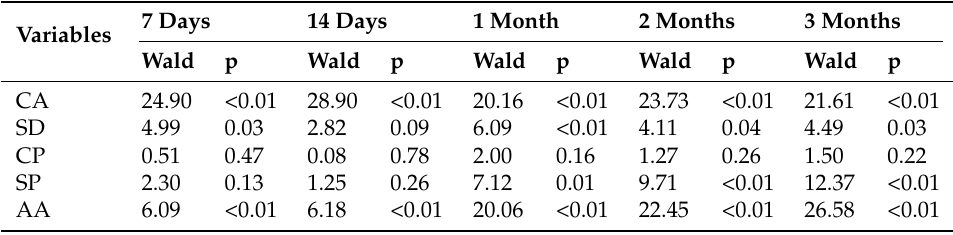
Table 2. Survival analysis with five user variables divided into five periods with Wald statistics and statistical significance showed.